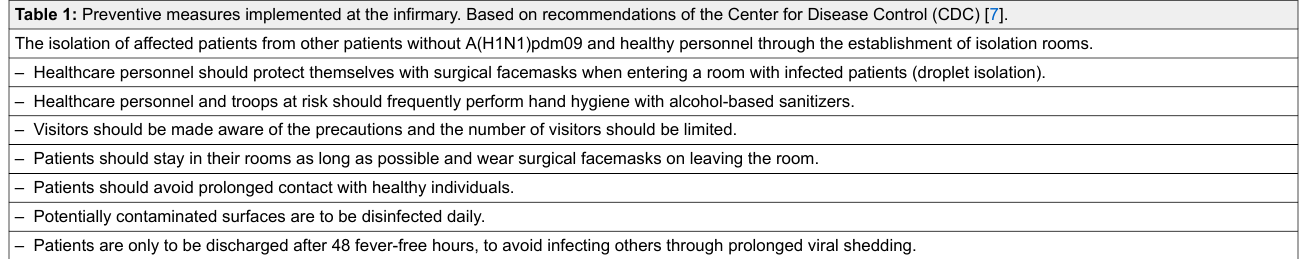
Table 1: Preventive measures implemented at the infirmary. Based on recommendations of the Center for Disease Control (CDC) [7]. The isolation of affected patients from other patients without A(H1N1)pdm09 and healthy personnel through the establishment of isolation